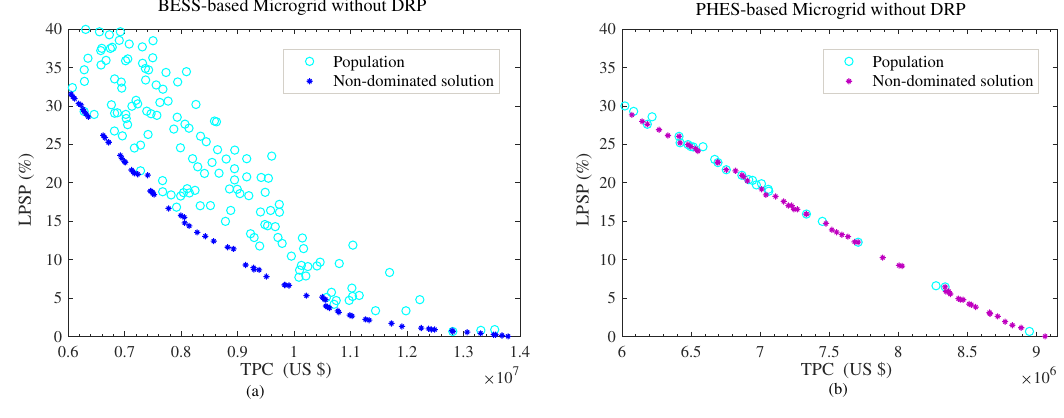
Figure 4. Pareto front plots for case 1. Table 3. Techno-economic analysis for case